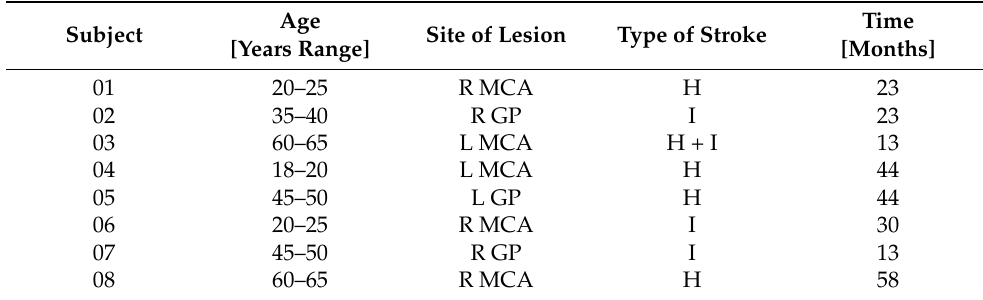
Table 1. Patients’ individual characteristics. R: right; L: left; MCA: middle cerebral artery; GP: globus pallidus; H: hemorrhagic; I: ischemic.